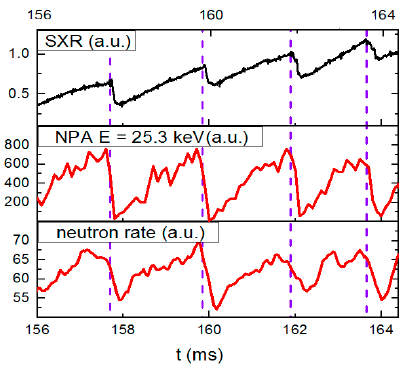
Figure 13. The time traces of signals during sawtooth oscillations in discharge #31965. From top to bottom: soft X-ray, 25.3 keV atomic flux, neutron rate. The figure is taken from [45] and reproduced with permission from IOP Publishing.